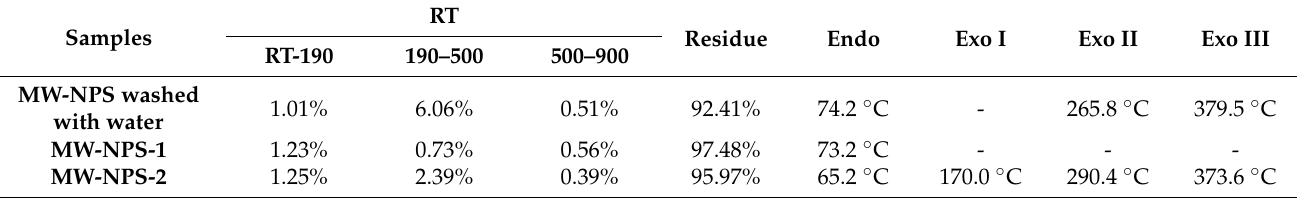
Table 1. Experimental data obtained from TGA